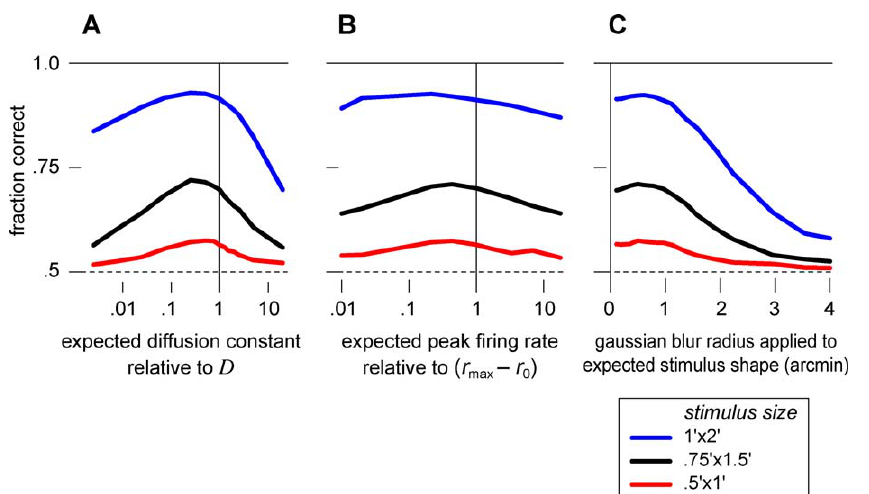
Figure 6. Markov Decoder Robustness to Mismatched Parameters (A) Discrimination performance when the decoder’s estimate for the trajectory statistics is wrong: The stimulus is known to perform a random walk on the retina, but the diffusion constant is misestimated. The performance is optimal for estimated values close to the actual diffusion constant and declines gently on either side. (B) Performance as a function of the expected stimulated firing rate, parameterized as ð r est (C) Performance as a function of the expected stimulus size, obtained by convolving the true stimulus shape with a spatial Gaussian of the specified radius. In each of these plots, parameters are the same as in Figure 5.